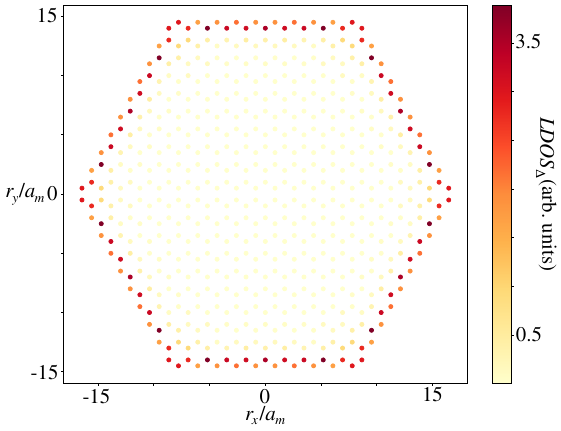
FIG. 3. In-gap local density of states in the QVH phase. We show the real-space plot of the local density of states integrated over 1 . 66 < E=W < 2 . 00 , with U=W ¼ 0 . 5 . Here, r x;y is the position of the lattice sites in units of the moir´e lattice spacing, a m . The result is computed with open boundary conditions and parameters as in Table I from Appendix C.